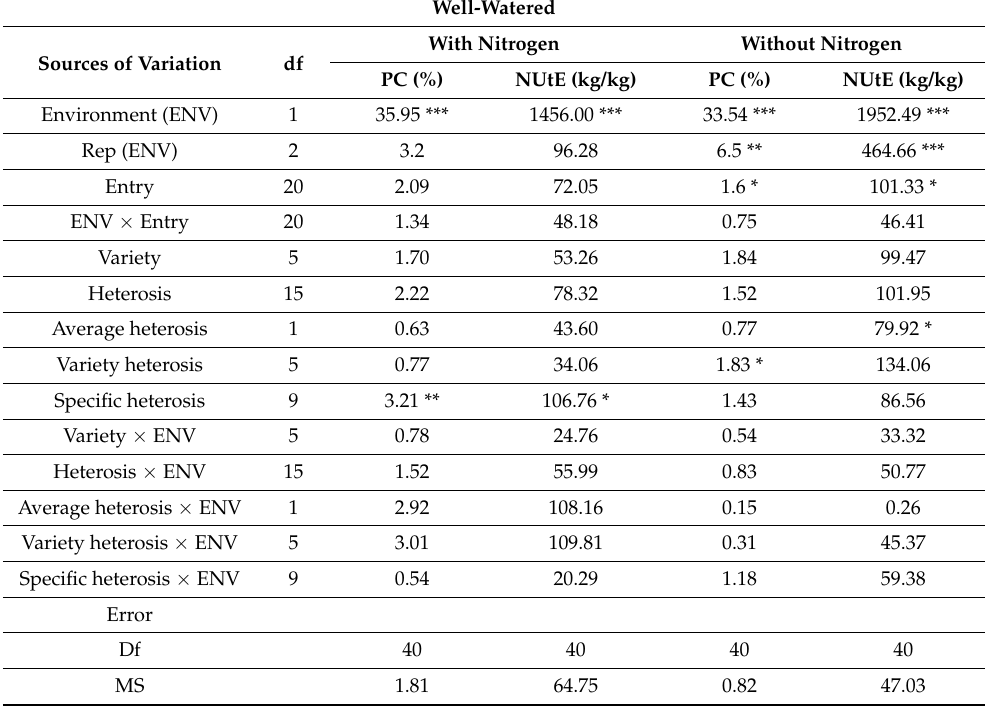
Table 7. Mean squares for grain protein content (PC) and nutrient utilization efficiency (NUtE) from analysis II of Gardner and Eberhart [77] of the diallel made with six Algerian maize populations evaluated along with four checks in two years in Algiers under drought and nitrogen